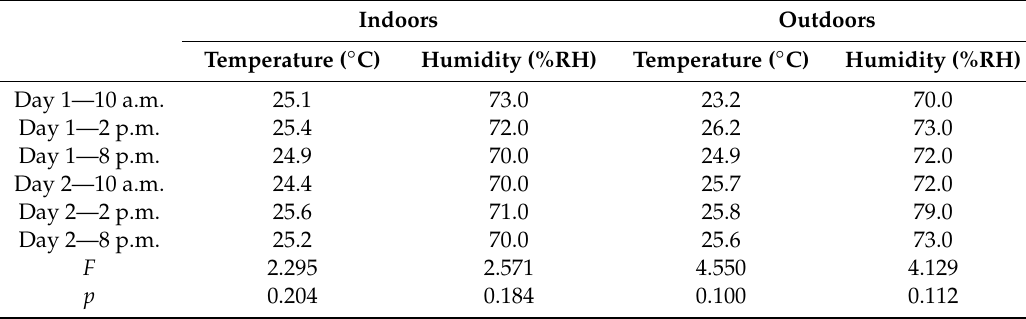
Table A1. The temperature and humidity during the